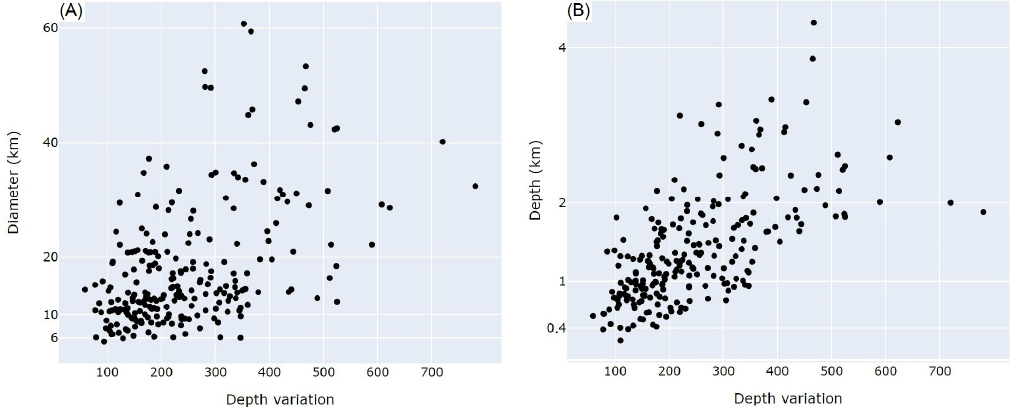
Figure 10. ( A ) diameter versus depth variation of all craters. ( B ) Depth versus depth variation of all craters. All craters plotted.